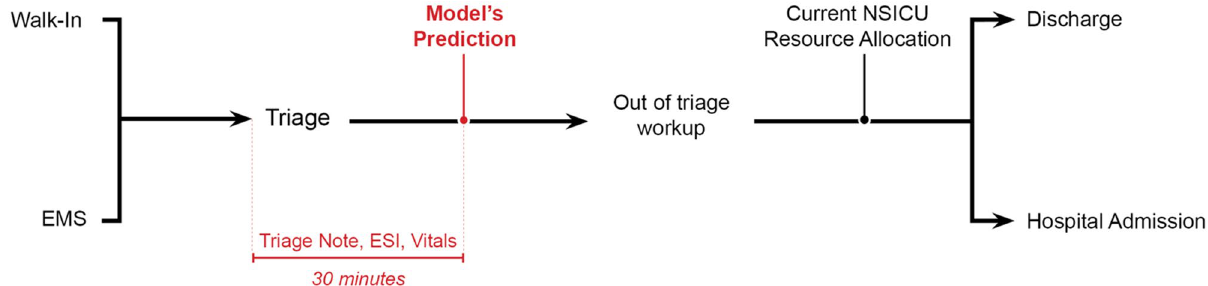
Figure 1. Diagram of patient flow through our institutional emergency department. Patient movement occurs from far left (arrival) to far right (final disposition). Current-state triage point to the neuroscience intensive care unit appears to the right. Proposed triage point and predictive time window appear in red. EMS emergency medical services, ESI emergency severity index, NSICU neuroscience intensive care